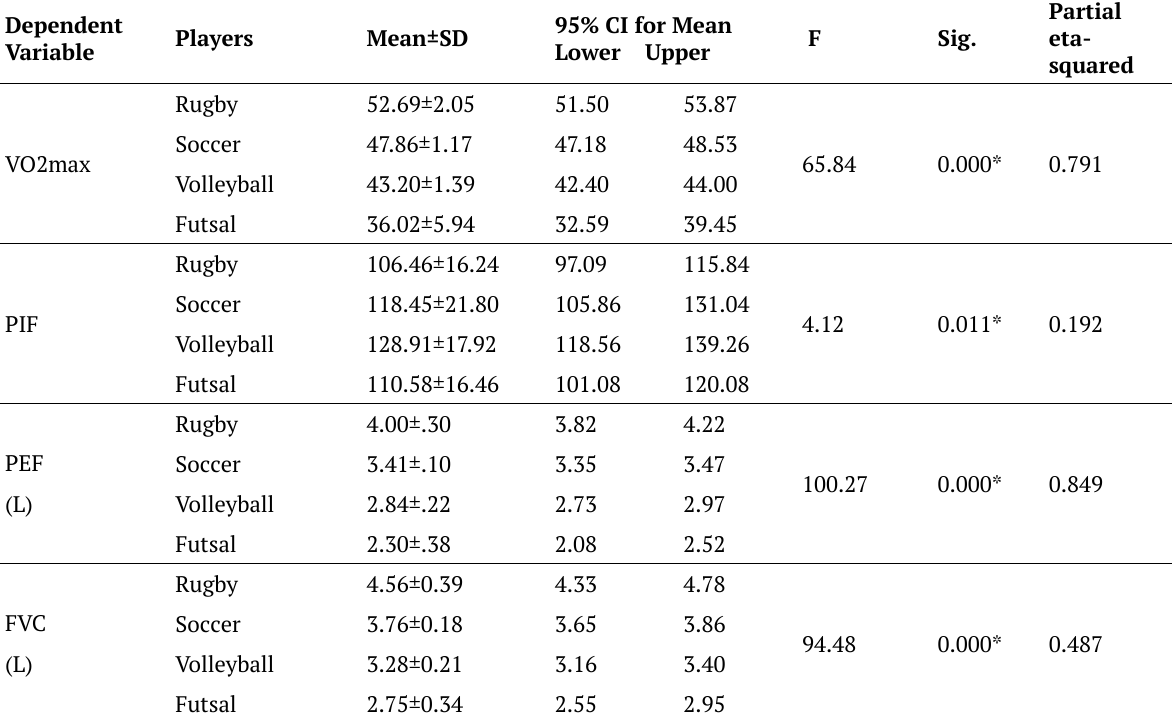
Table 2. Changes in the body composition of the competitive runners before and after the tests Dependent Variable